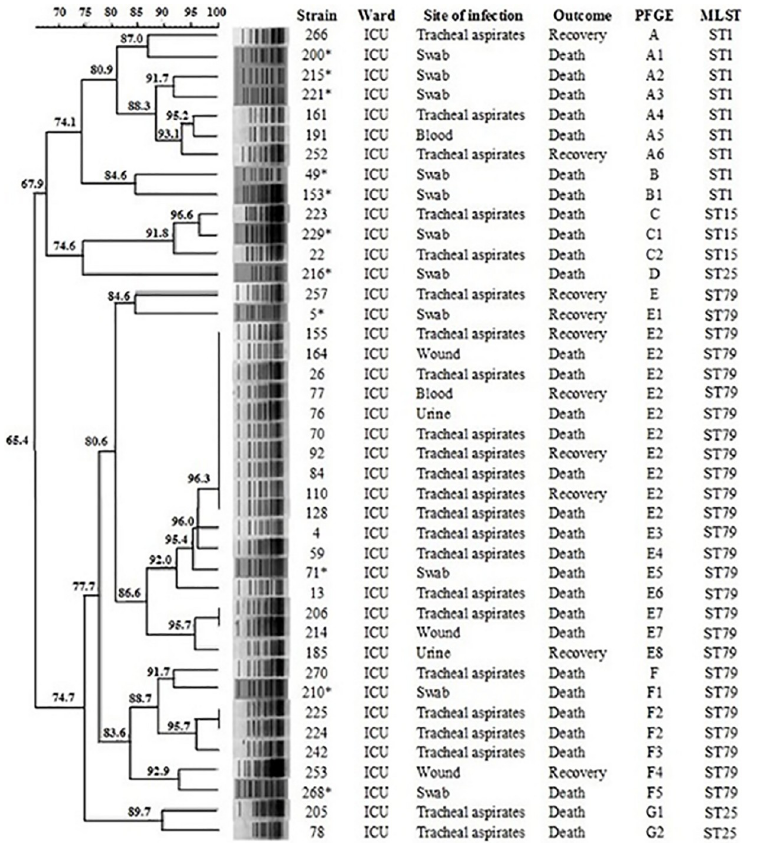
Fig 3. Dendrogram displaying the genetic relatedness of 41 OXA-23-producing A . baumannii strains recovered in a Brazilian ICU, based on PFGE data and MLST content. Asterisks indicate the colonizing strains.